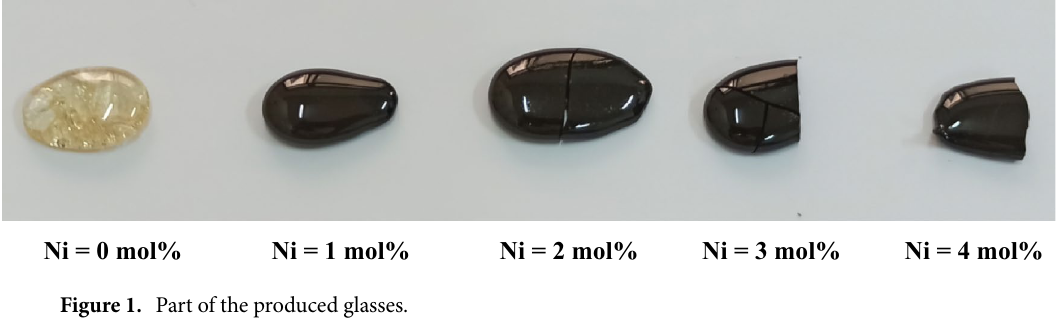
Figure 1. Part of the produced